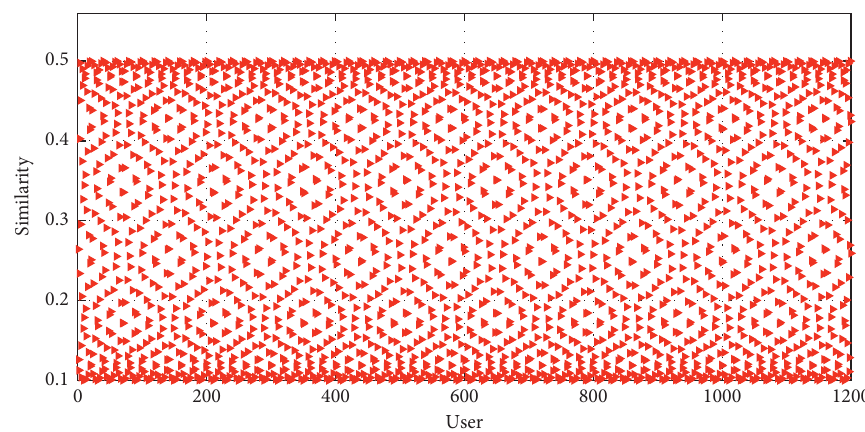
Figure 6: The distribution of similarity among users under the modified cosine